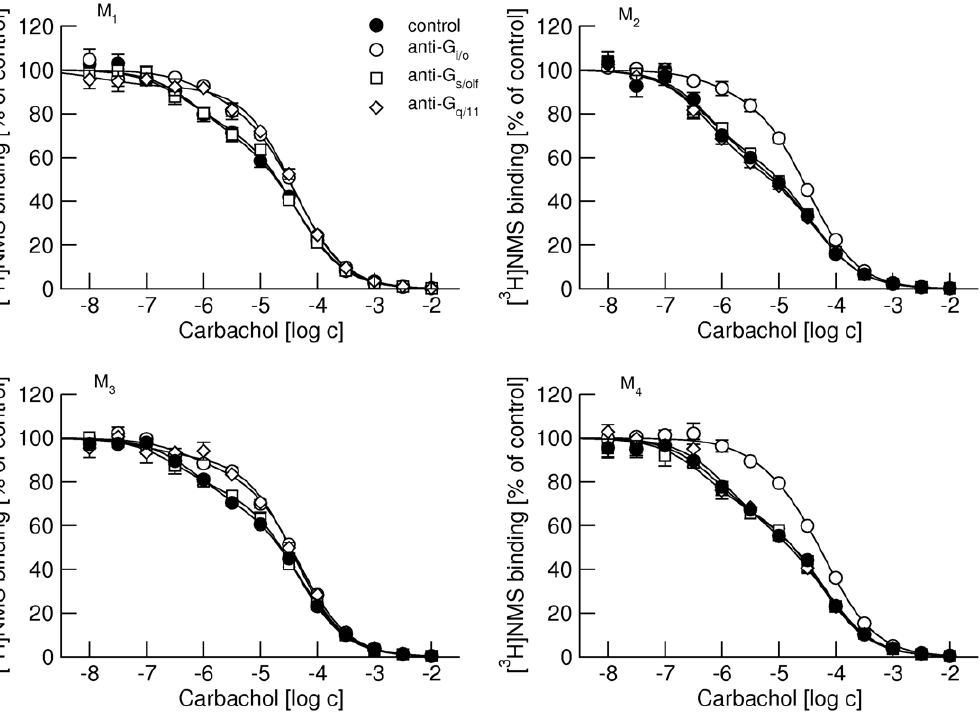
Figure 2. Effects of anti-G-protein antibodies on competition between carbachol and [ 3 H]NMS binding at M 1 to M 4 receptors. Binding of 1 nM [ 3 H]NMS to membranes from CHO cells expressing M 1 (upper left), M 2 (upper right), M 3 (lower left) and M 4 (lower right) receptors in the presence of increasing concentrations (abscissa, log M) of carbachol is expressed as per cent of control binding in the absence of carbachol. Filled circles, control binding in the absence of antibodies. Open symbols, binding in the presence of anti-G i/o (circles), anti-G s/olf (squares), and anti-G q/11 (diamonds) antibodies. Data are means 6 S.E.M of values from 3 experiments performed in quadruplicates. Curves were fitted using equation 3 and results of fits are shown in the Table 2.